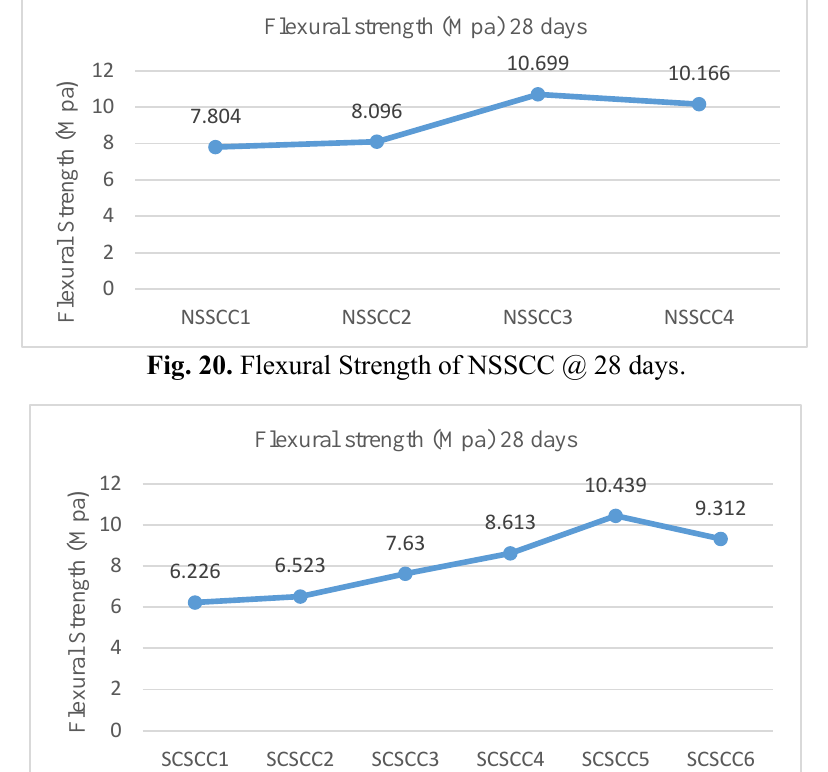
Fig. 21. Flexural Strength of SCSCC @ 28 days.